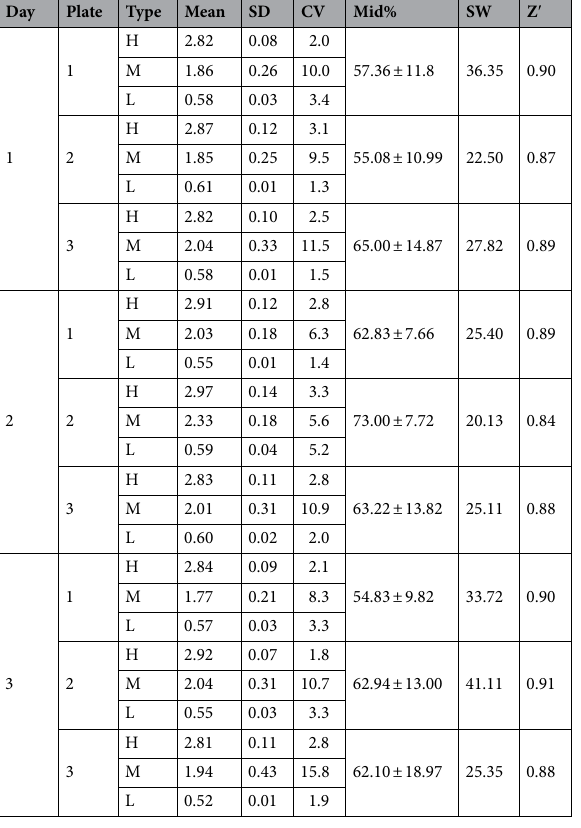
Table 2. Data of the (intra) plate uniformity study for expression temperature 30 °C. H: high signal; M: medium signal; L: low signal; SD: standard deviation; CV: coefficient of variation; Mid%: normalised mid signal; SW: signal window; Z’: Z’ factor. All Max (high) and Mid signal (unnormalized) CV’s < 20%. All normalized mid signal (mid%) SD’s < 20. All min (Low) SD’s < Min (Max (High) SD, mid SD). All SW’s > 2 and Z’ > 0.4. Z’ and CV’s were calculated taken in consideration two repeats per HGD variant. Within-day fold shifts and between-day fold shifts were below two indicating that assay robustness can be guaranteed when expression temperature 30 °C is